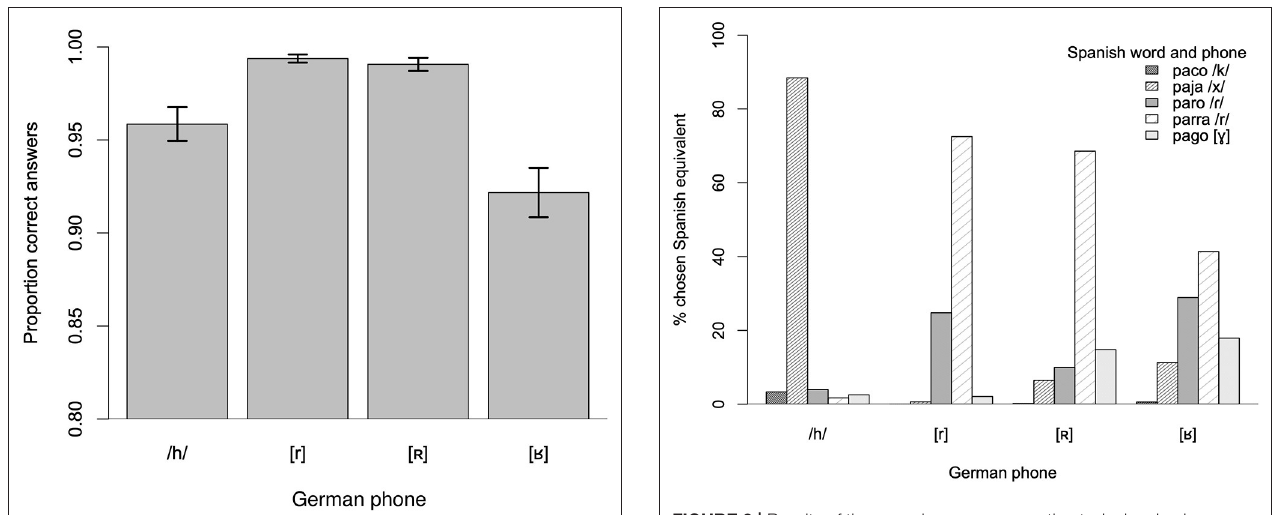
FIGURE 2 | Results of the cross-language perception task showing how consistently a given Spanish word was chosen as containing the best matching phone to German /h/ and each of the allophones of